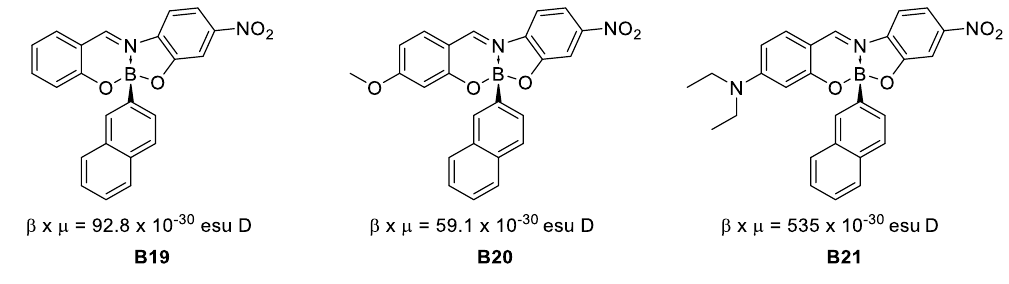
Figure 16. Schiff bases with second-order NLO properties.